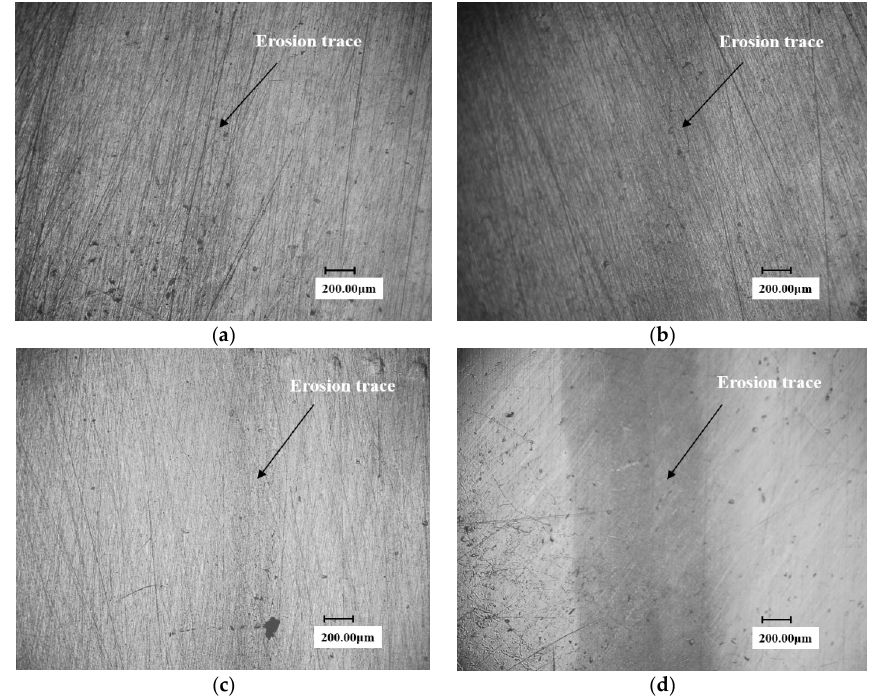
Figure 9. The surface micrograph of stellite alloy specimen at 450 minutes. ( a ) 30° sample (erosion trace width: 200 μ m); ( b ) 60° sample (erosion trace width: 380 μ m); ( c ) 90°sample (erosion trace width: 400 μ m); ( d ) laser cladding 90° sample (erosion trace width: 800 μ m).